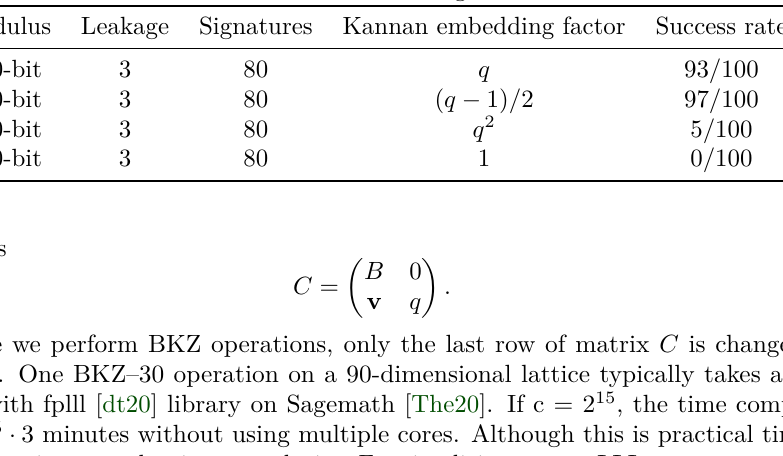
Table 4: Kannan embedding factor